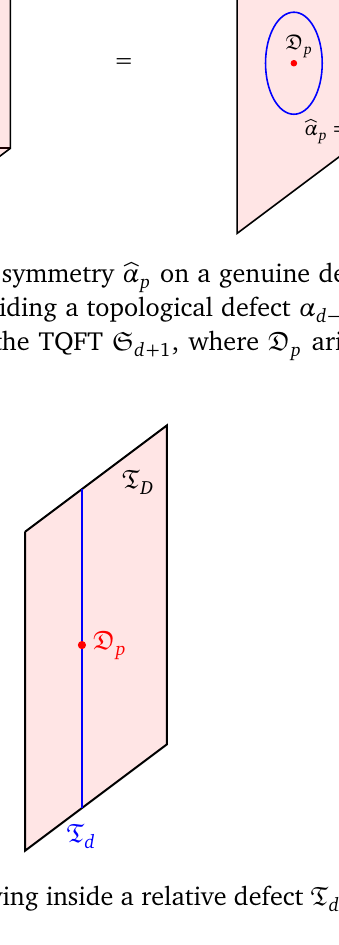
of a theory T d